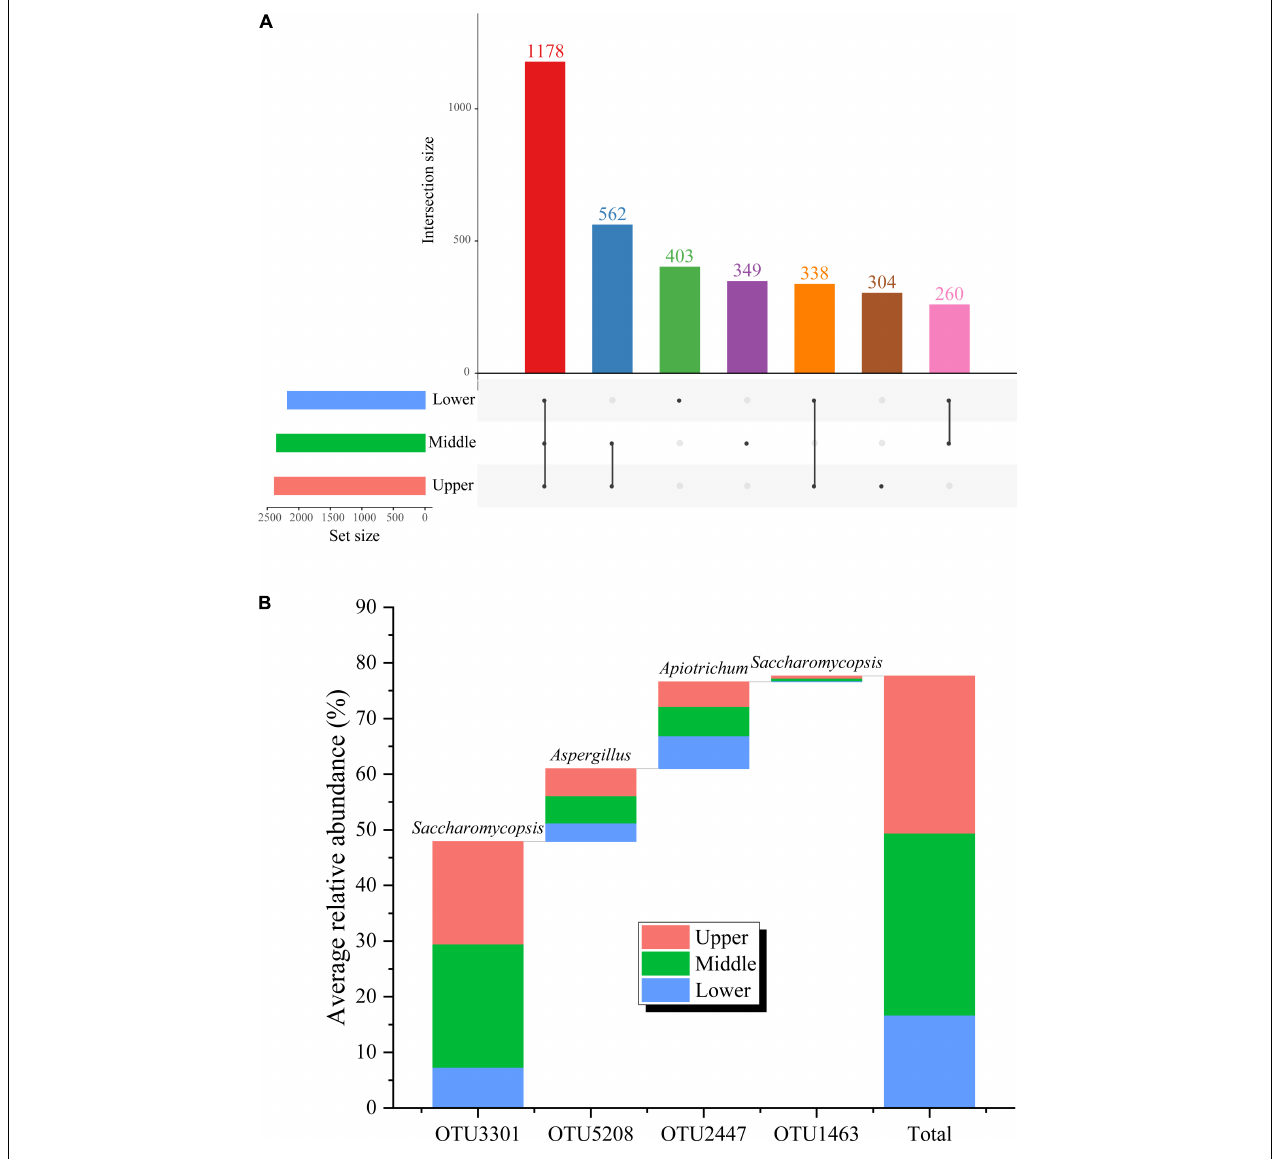
FIGURE 4 | Fungal shared OTUs in PM samples at different depths (A) and average relative abundance (B) of core OTUs in PM